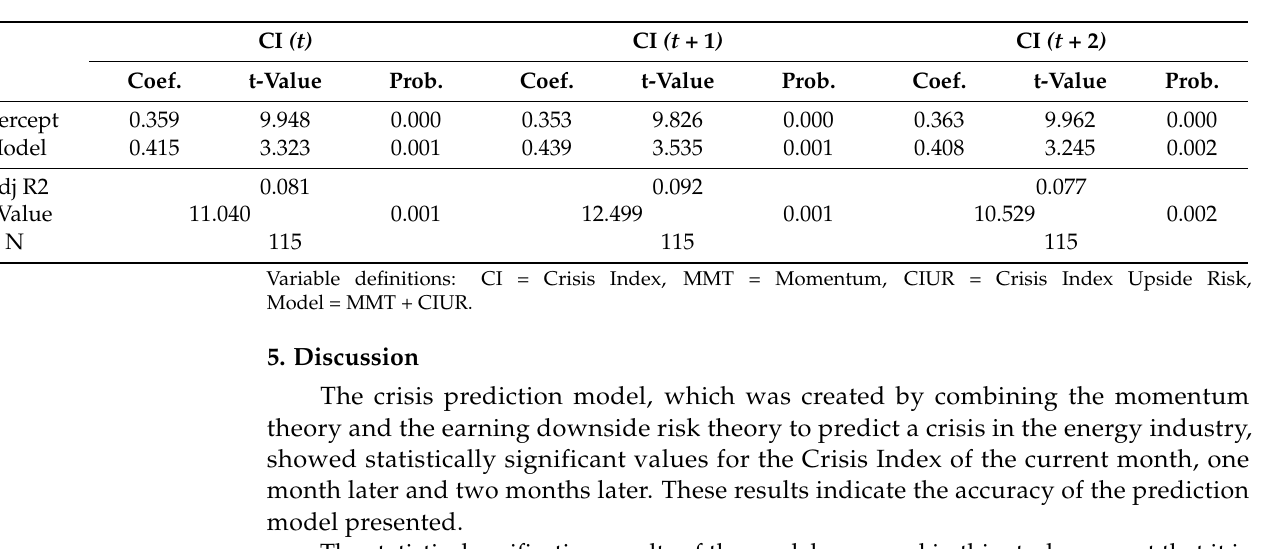
Table 4. Result of the OLS Regression Analysis of the Effect of the Crisis Index Prediction Model on Future Crisis